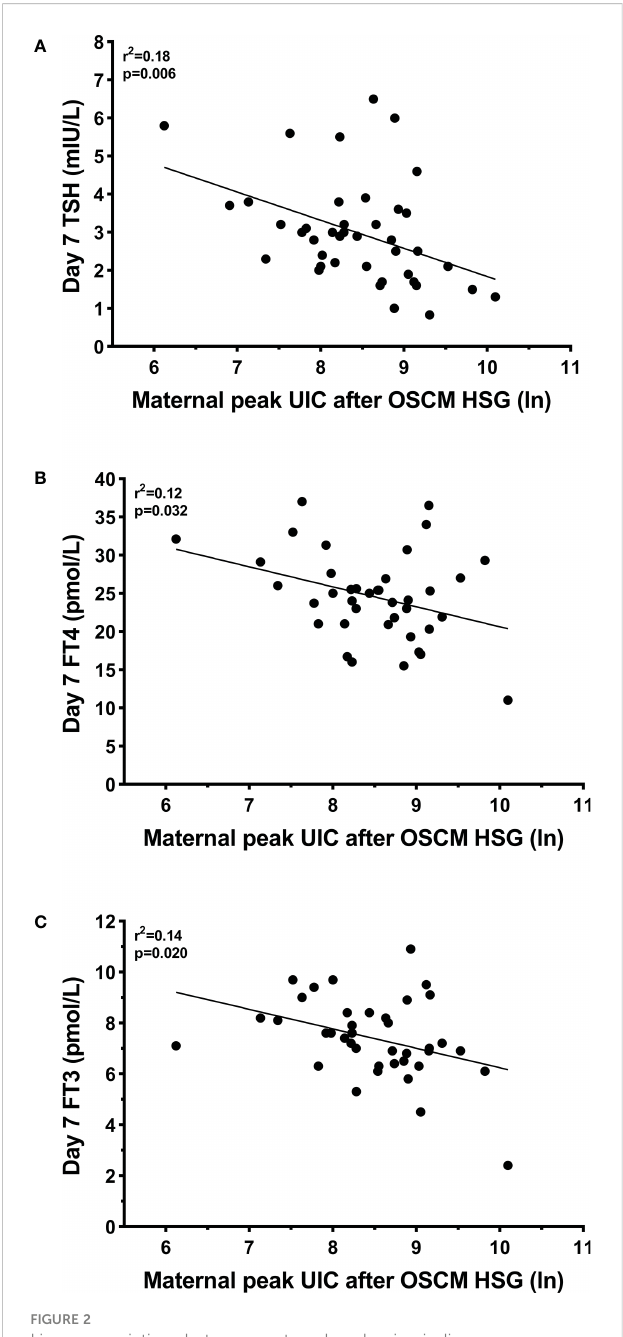
FIGURE 2 Linear associations between maternal peak urine iodine concentrations (UIC) during pregnancy and Day 7 thyroid function parameters (serum) in the offspring: (A) thyroid-stimulating hormone (TSH); (B) free thyroxine (tetraiodothyronine – FT4); and (C) free triiodothyronine (FT3). Peak UIC values were log-transformed to approximate a normal distribution. Diagonal grey lines are the fi tted linear regressions, with their respective coef fi cients (r 2 ) and p -values provided within each panel. HSG, hysterosalpingography; and OSCM, oil-soluble contrast